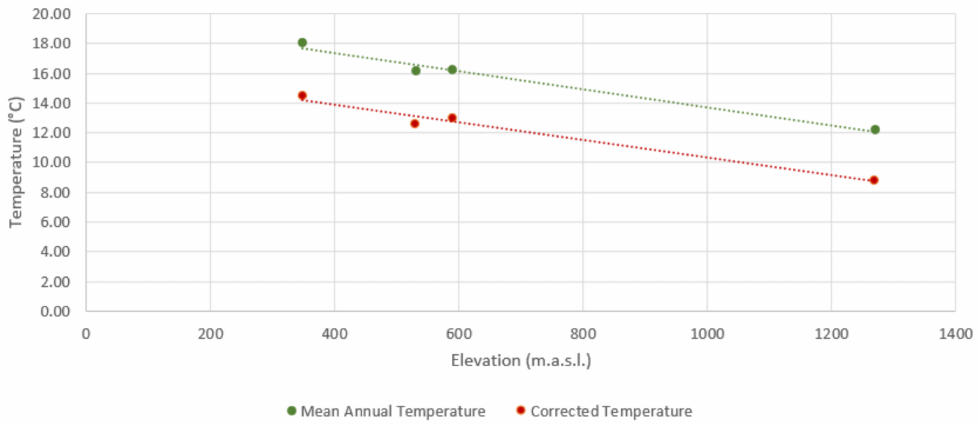
Figure 5. Linear regressions between temperature ( ◦ C) (mean annual temperature in green and corrected temperature in red) and elevation (m a.s.l.).